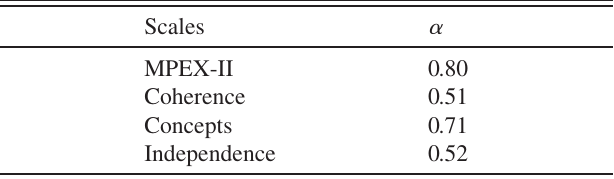
TABLE VI. Cronbach’s alphas for the Turkish MPEX-II and its three dimensions after the second factor analysis.